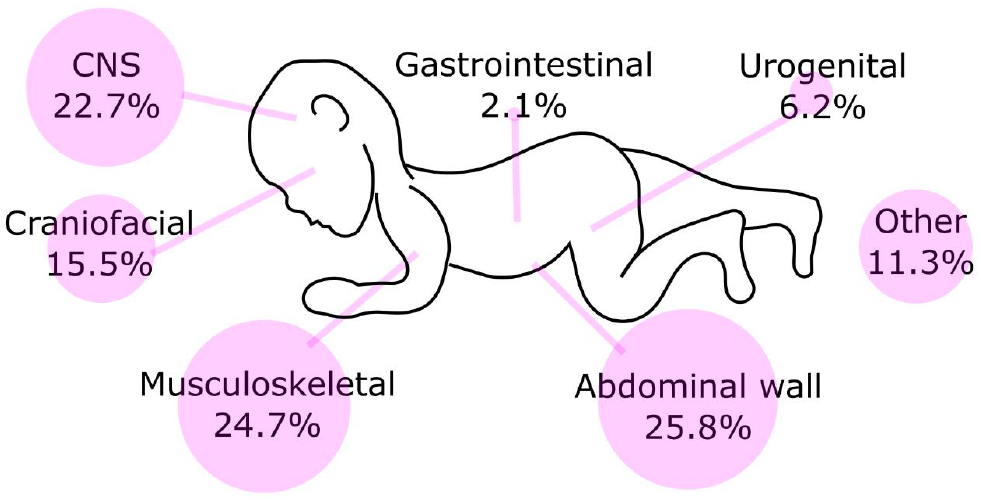
Figure 1. Associated defects among cases with NTDs in five counties in Shanxi province of Northern China, 2002 – 2021.